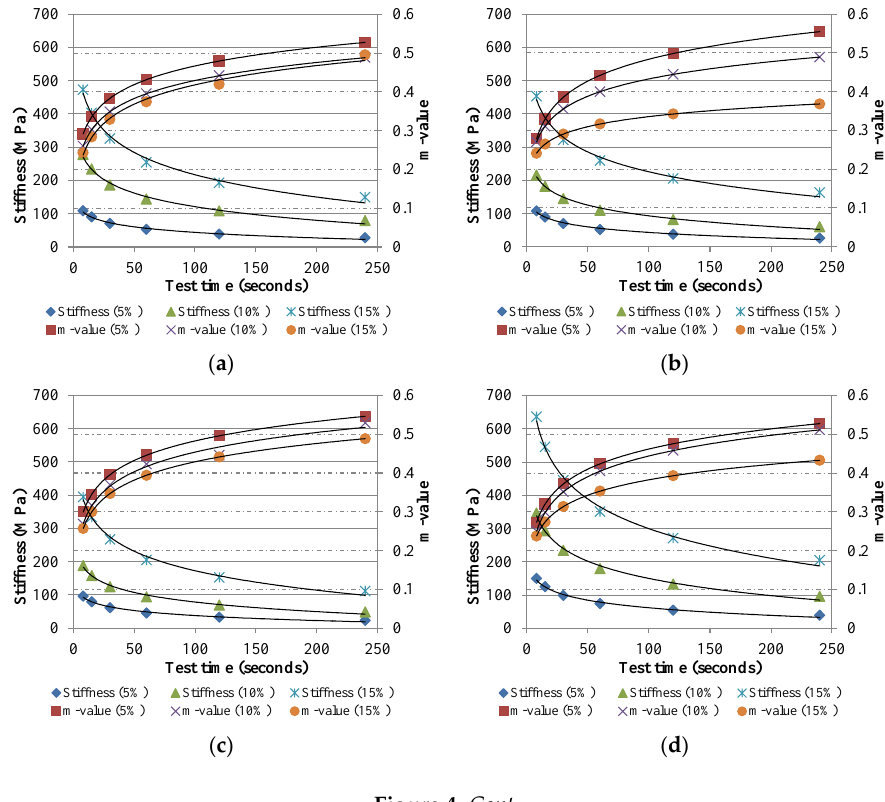
Table 2. Minimum low temperatures of RAP sources A–F with virgin binder PG